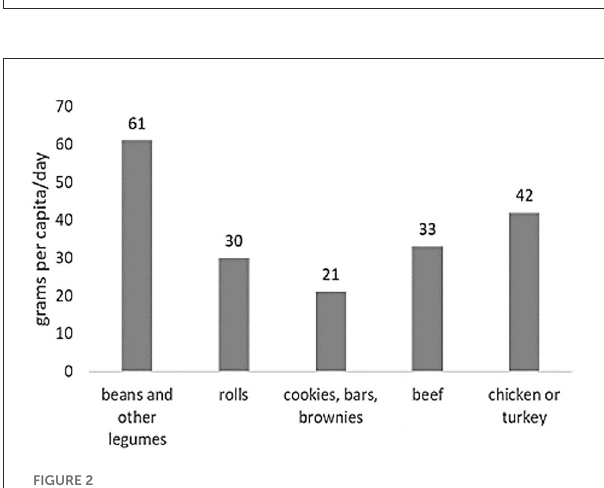
FIGURE2 Per capita daily intake (g/day) of the five most relevant sources of iron in the diet of Brazilian children aged 4–8 years old.